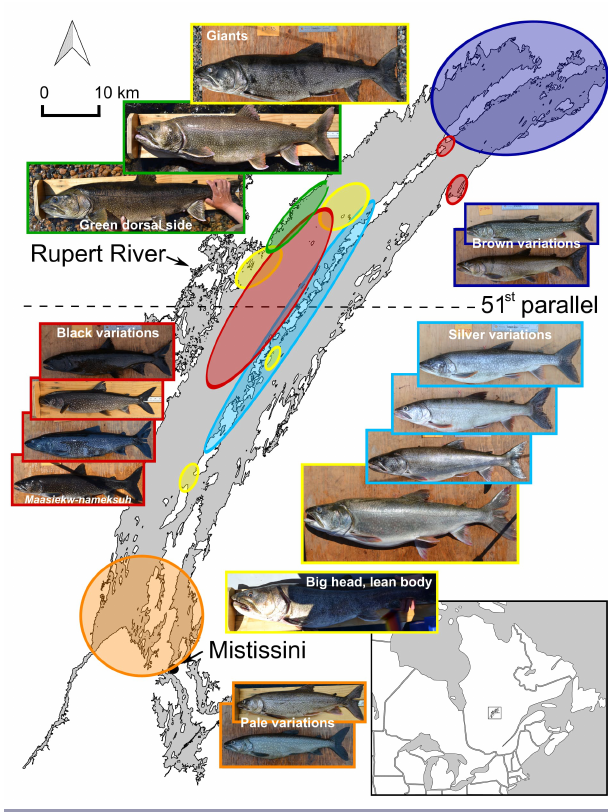
Fig. 1 . Geographic location of Mistassini Lake, Québec showing examples (inset photos) of the lake trout variations and their geographical summer distribution (colored ellipses) as described by multiple Cree First Nation